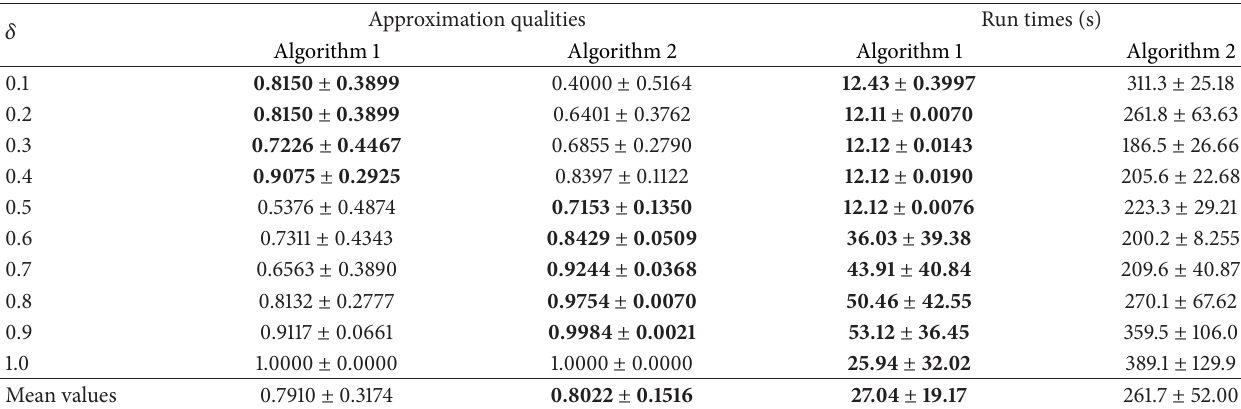
Table 6: The comparison between decision-monotonicity criterion based reducts and cost based reducts